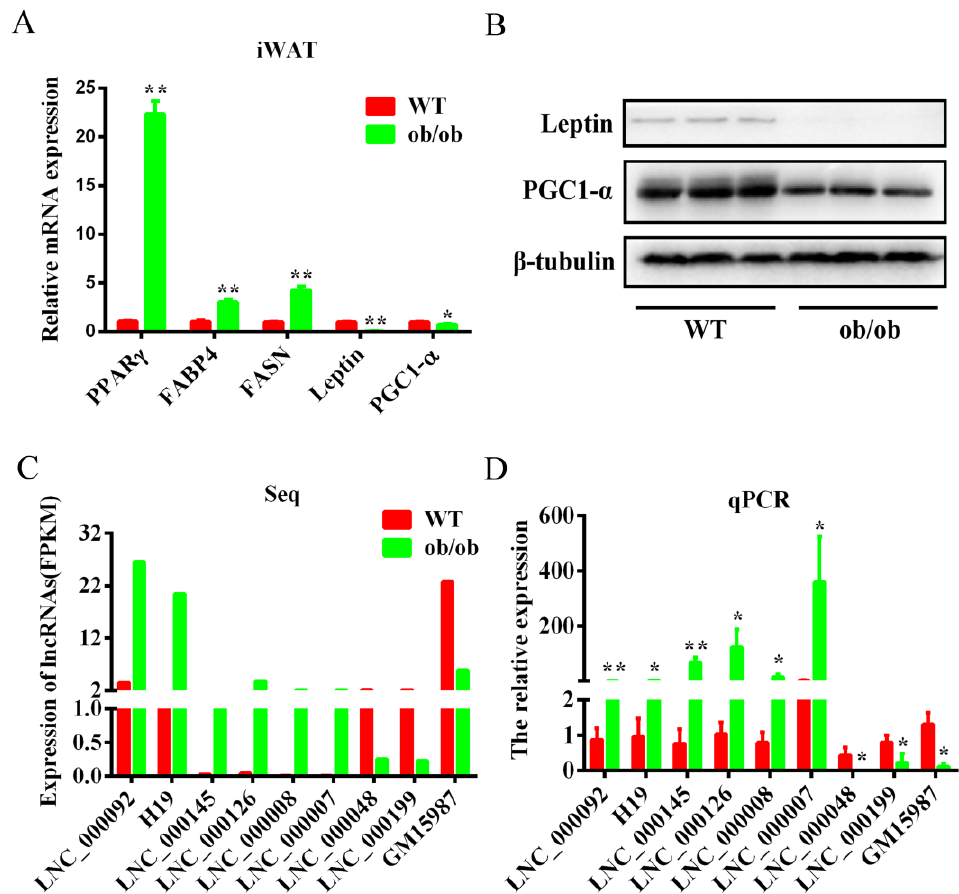
Figure 4. Validation of the differentially expressed lncRNAs by qPCR. ( A ) mRNA expression levels of adipogenic marker genes in WT and ob/ob mice. ( B ) Protein expression levels of leptin and PGC1-a in the iWAT of WT and ob/ob mice. ( C ) Sequencing FPKM values of nine lncRNAs. ( D ) The lncRNAs were validated by qPCR assays. Data are expressed as the mean ± SEM (n = 5). * p < 0.05, ** p < 0.01.